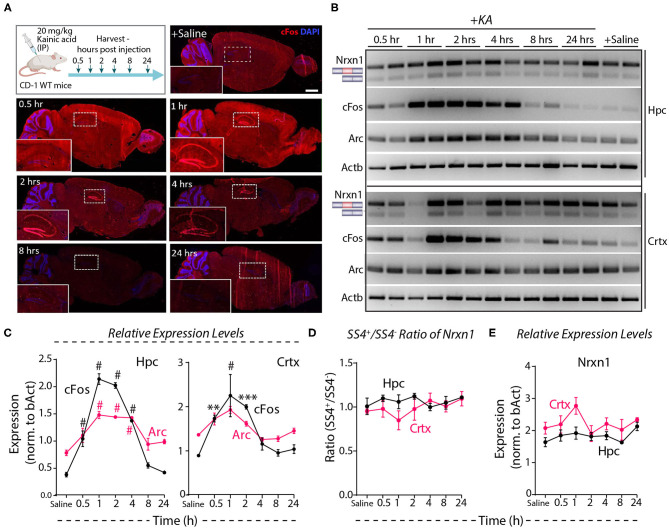
Neuronal activity induced by systemic KA administration does not lead to Nrxn1 SS4 alternative splicing. (A) Experimental paradigm where CD-1 WT mice received 20 mg/kg KA and brains were collected at indicated time points. IHC images show induction of cFOS expression in hippocampus (insets) at 1 h and continued expression until 24 h post-injection. (B) RT-PCR for Nrxn1 SS4 splicing, cFos, Arc expression in hippocampus (Hpc) and cortex (Crtx) at different time points after KA injection. (C) Quantification of relative expression levels of cFos and Arc show significant induction between 0.5 and 4 h in Hpc and 0.5 and 2 h post-KA injection in Crtx (# = p < 0.0001, ** = p 0.0067, *** = p 0.0002). (D) Quantification of Nrxn1 SS4+/– ratio shows no significant difference in Hpc and Crtx across all time points post-KA injection. (E) Quantification of relative expression levels of total Nrxn1 show no major change across different time points in Crtx and Hpc. All numerical data are represented as means ± SEM. Statistical significance was calculated by two-way ANOVA using Tukey's multiple comparison test. Scale bar 100 μm.